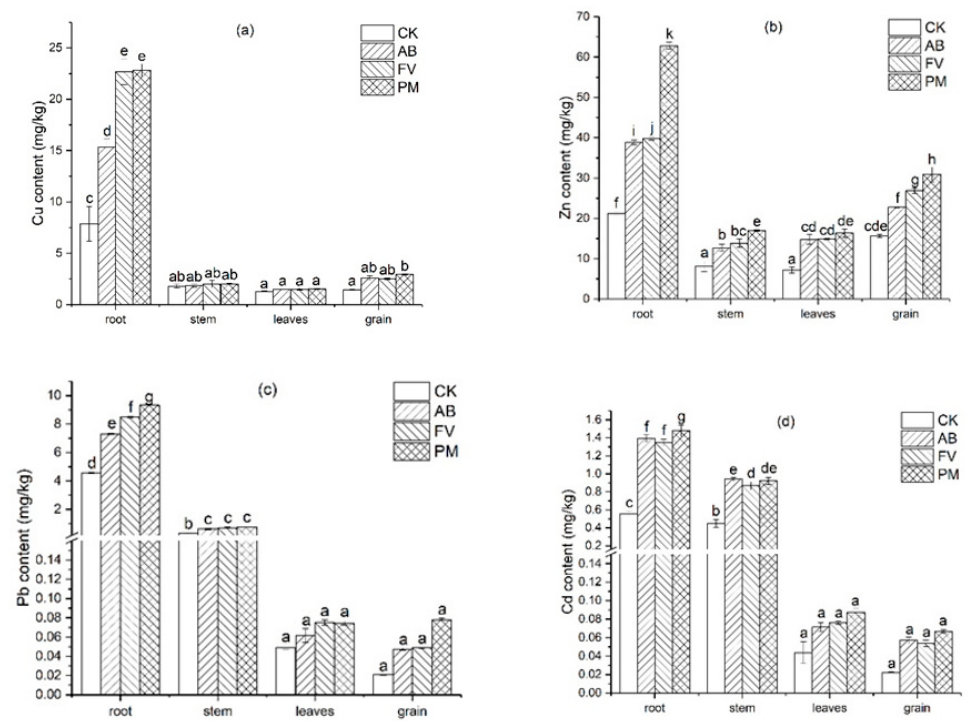
Figure 9. ( a ) Distribution of Cu content in the rice plants on the fourth experimental year; ( b ) distribution of Zn content in the rice plants on the fourth experimental year; ( c ) distribution of Pb content in the rice plants on the fourth experimental year; ( d ) distribution of Cd content in the rice plants on the fourth experimental year. Data are expressed as means ± SD; n = 3. Different letters on data in the same group indicate a significant difference between them at p < 0.05 level.